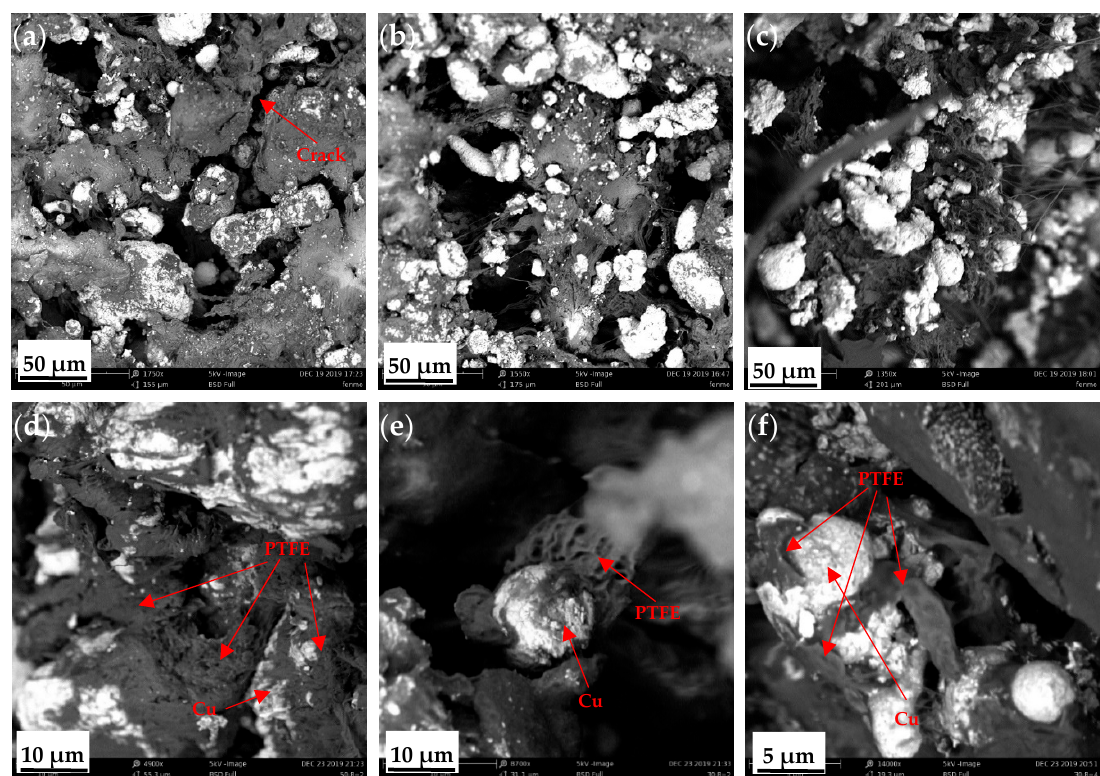
Figure 11. SEM images of impact sections in PTFE/Cu composites with different densities: ( a ) 50- μ m scale PTFE/Cu-1; ( b ) 50- μ m scale PTFE/Cu-2; ( c ) 50- μ m scale PTFE/Cu-3; ( d ) 10- μ m scale PTFE/Cu-1; ( e )10- μ m scale PTFE/Cu-2; ( f ) 5- μ m scale PTFE/Cu-3.